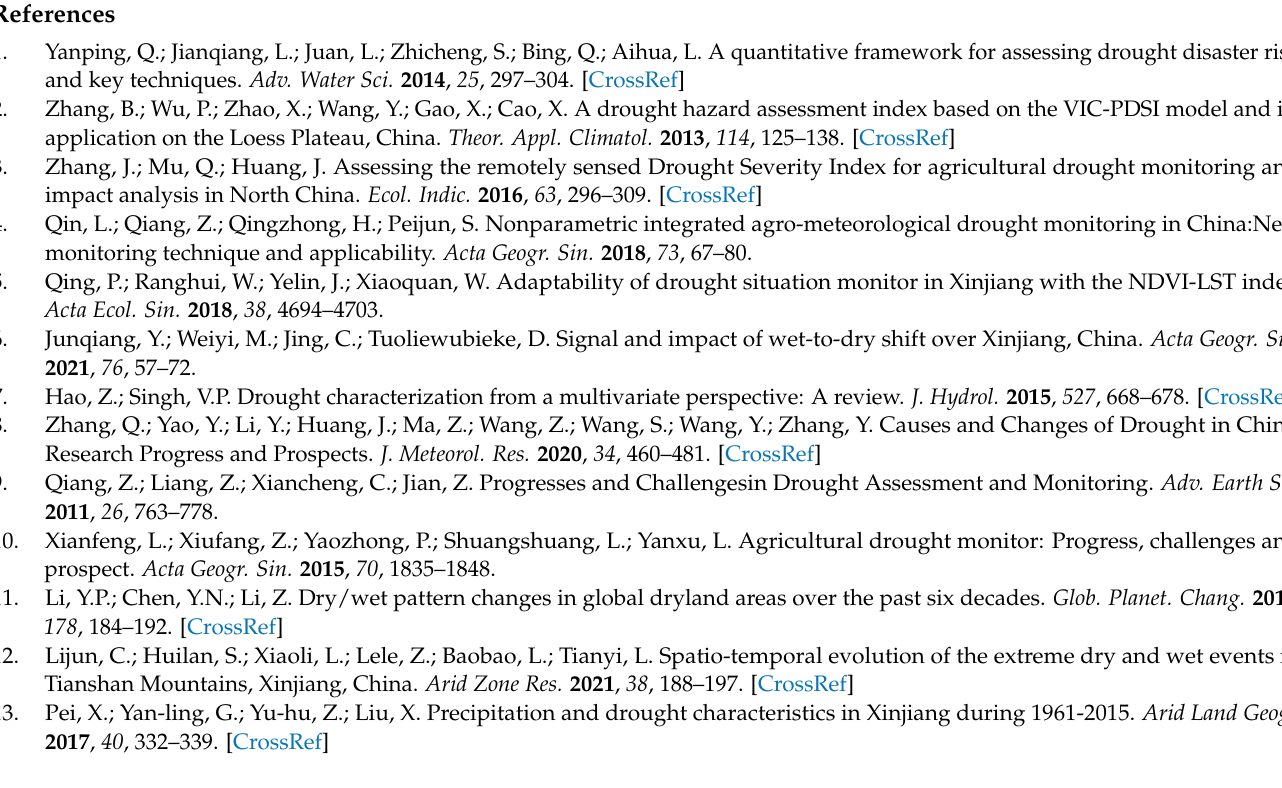
Figure A2. The semi-variogram fitting procedure of P ( a ), ET 0 ( b ), and AI ( c ).